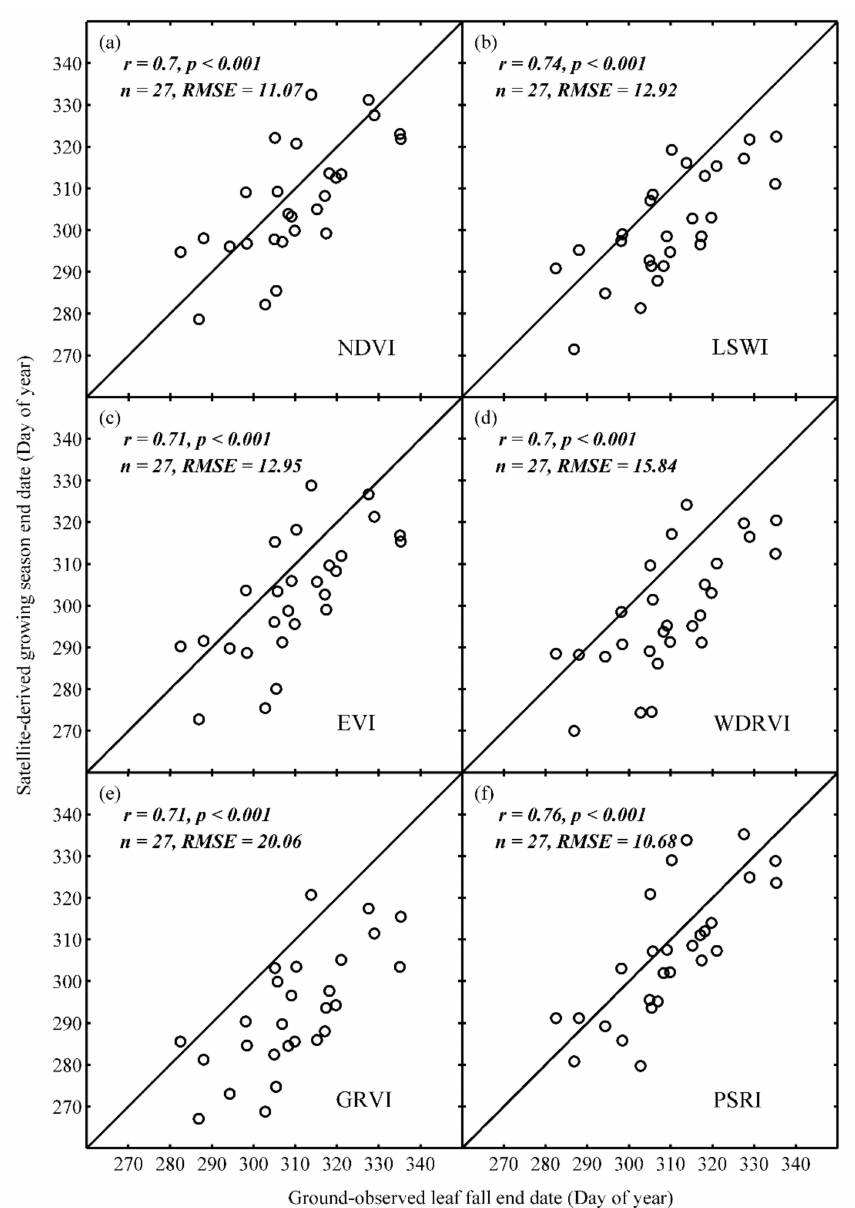
Figure 4. Correlation coe ffi cients and errors (RMSE) in spatial series between multi-year mean growing season end dates retrieved from di ff erent VIs and multi-year mean ground-observed leaf fall end dates over 27 stations /